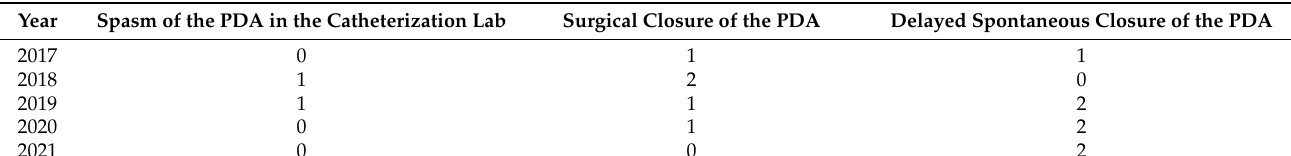
Table 3. Table representing the evolution of the stopped procedures over the years.